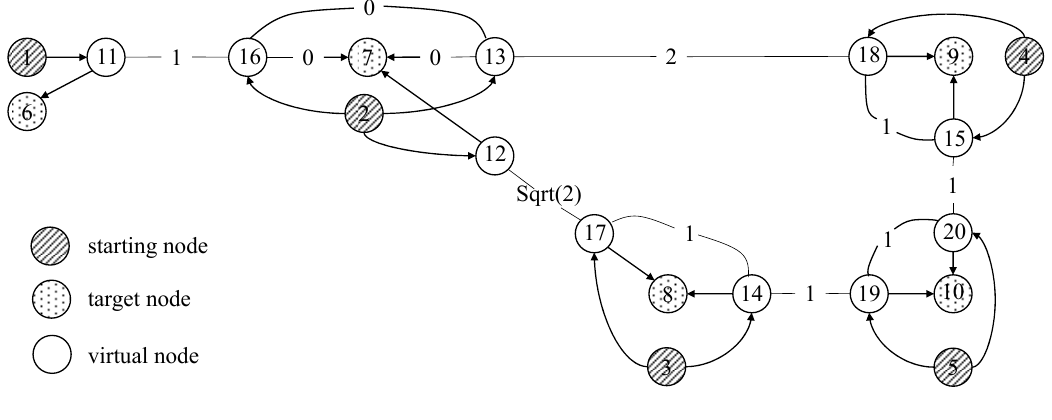
Figure 8. Number of graph H.